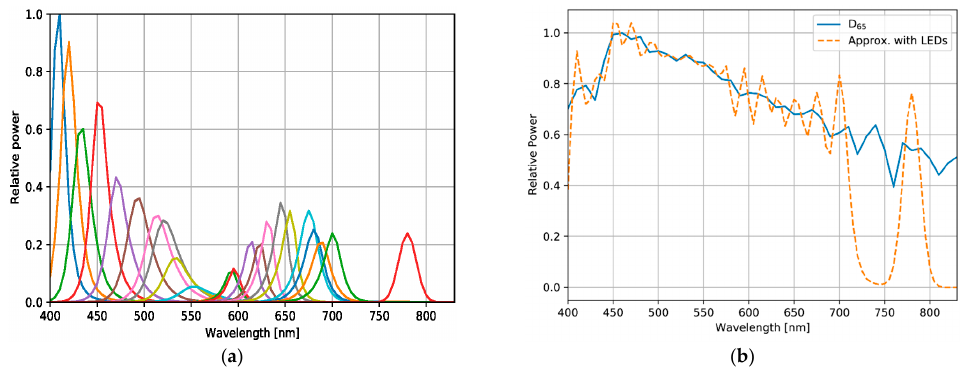
Figure 6. Sets of SPDs with real light-emitting diodes (LEDs): ( a ) measured SPD of 24 LEDs for sub-lights, and ( b ) approximation of an SPD of D65 standard illumination with SPDs represented in ( a ).